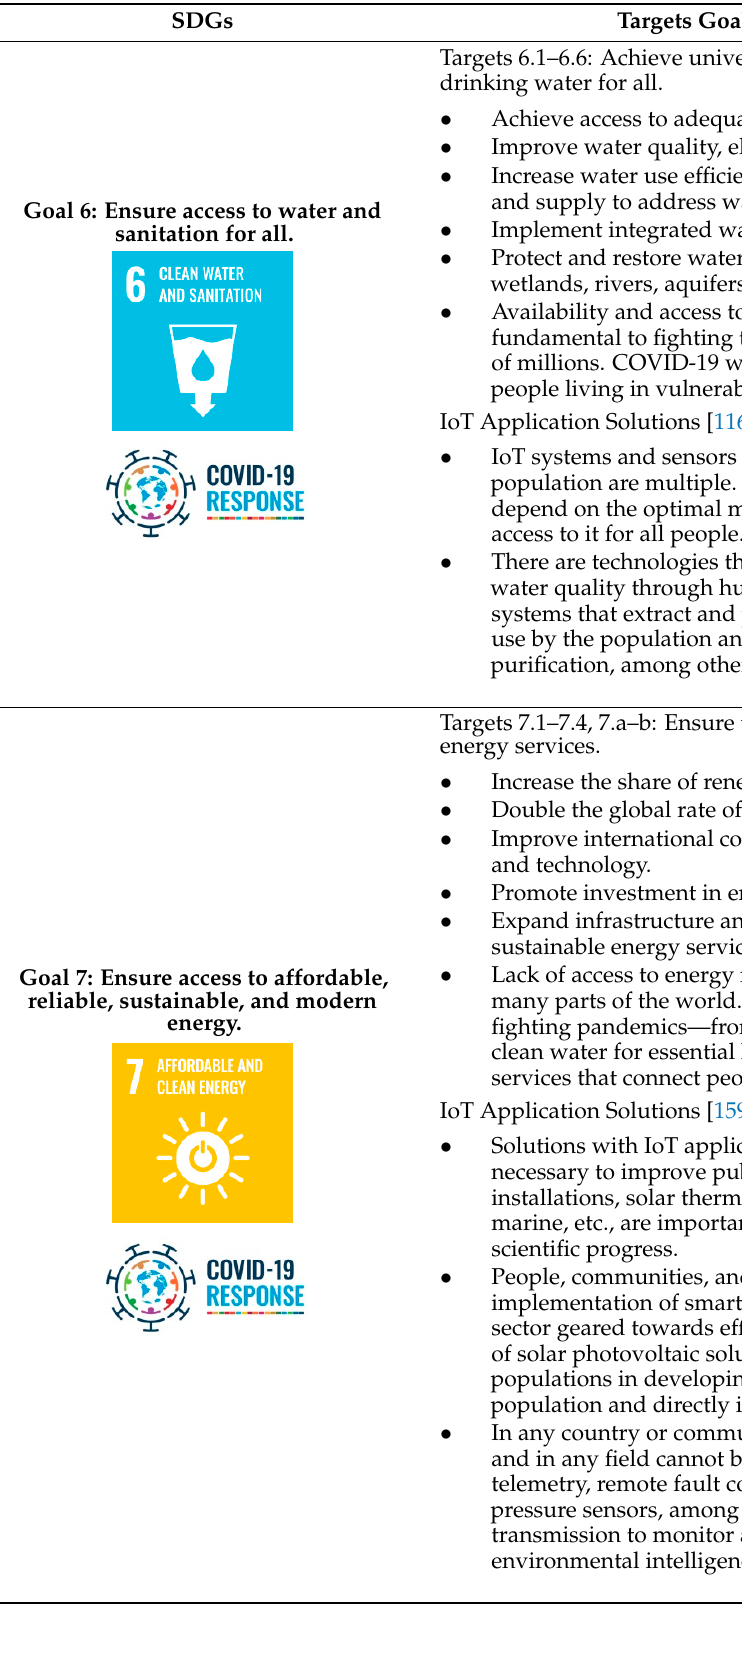
Table 5. Impact of the Sustainable Development Goals on IoT applications for improving health and the environment. SDGs Targets Goals and Application to IoT Systems Table 5. Cont. Targets Goals and Application to IoT Systems